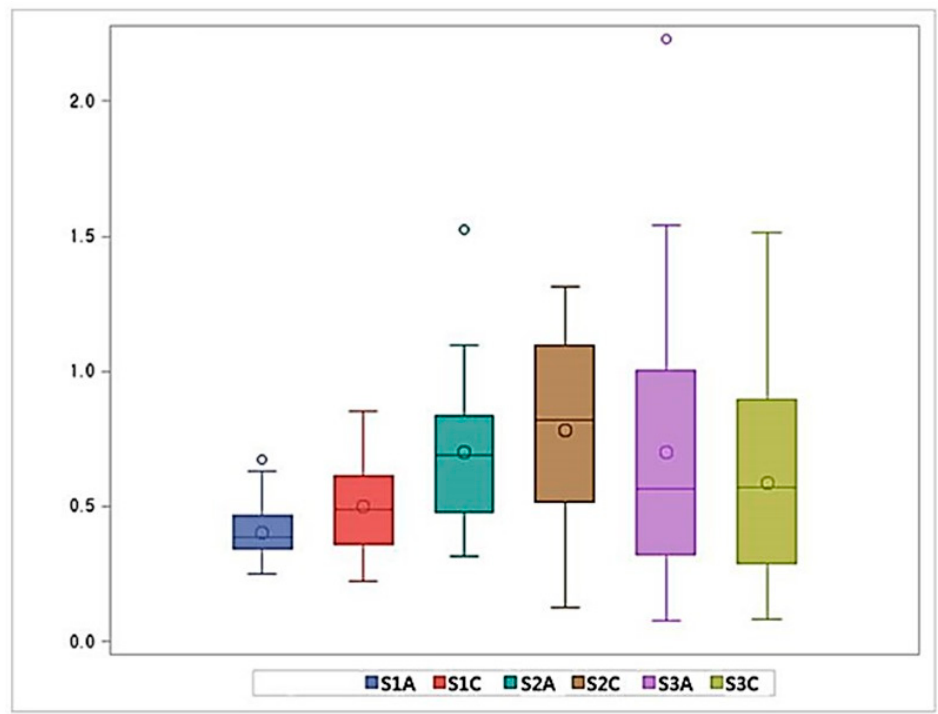
Figure 10. The widest canal width (mm).